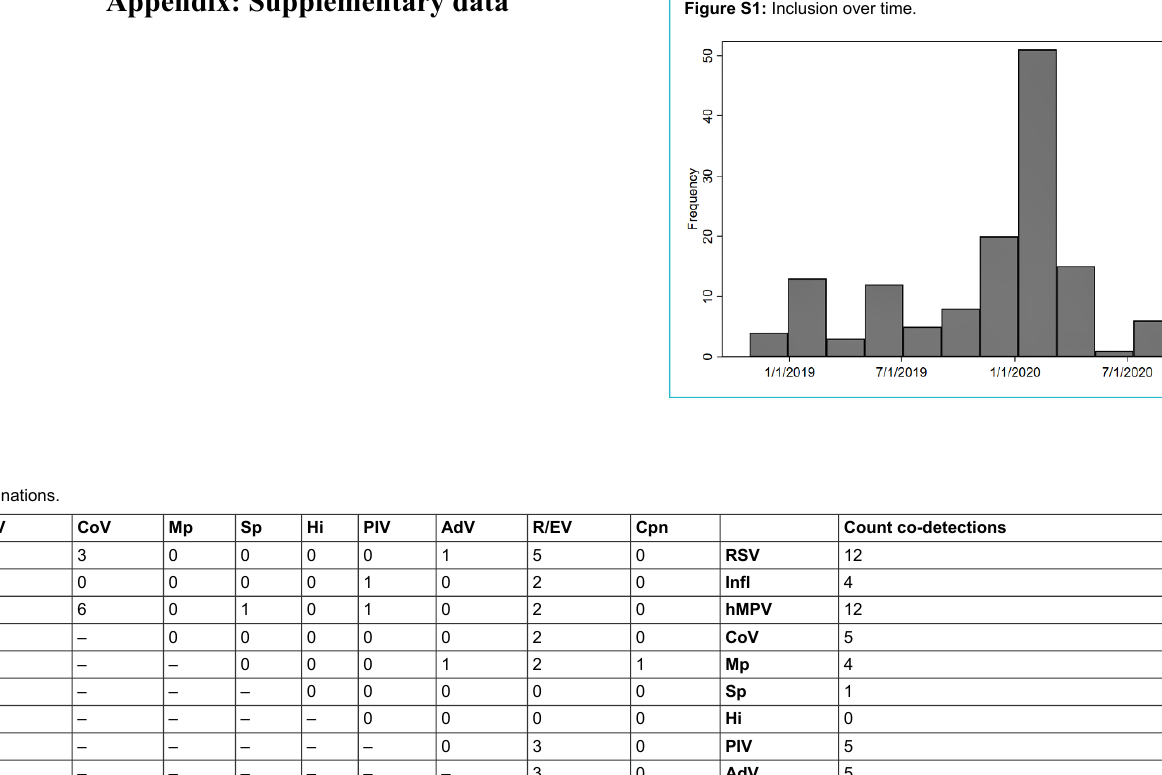
Figure S1: Inclusion over time.